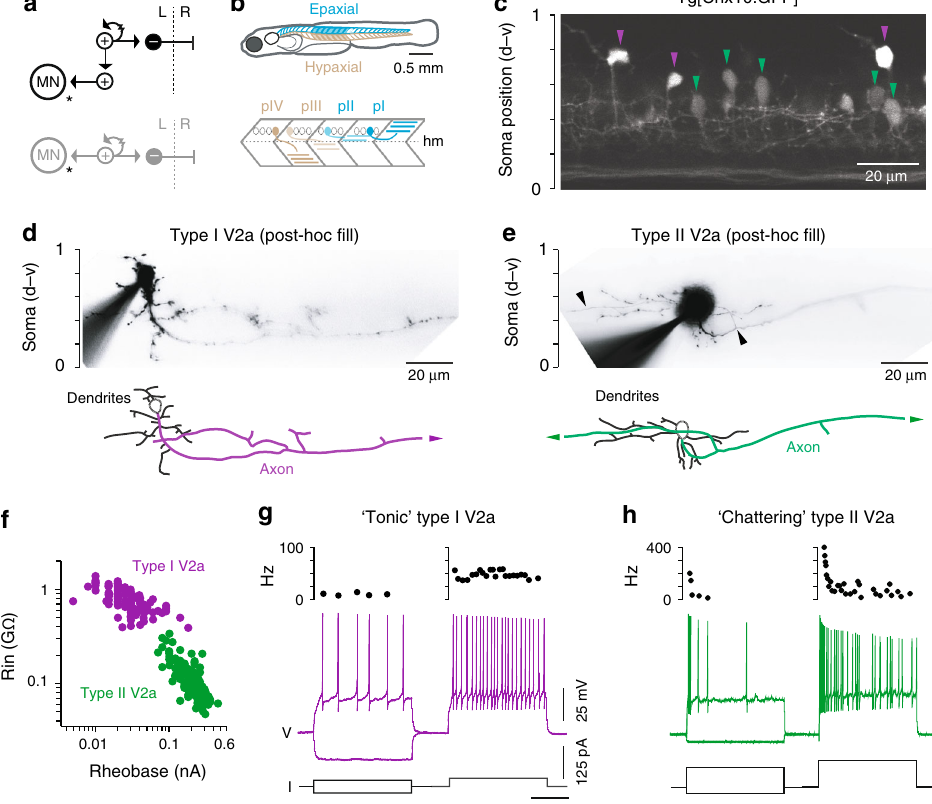
Fig. 1 Two types of V2a neuron distinguished by intrinsic properties. a Schematics illustrating multi-layer (top) and single-layer (bottom) models of connectivity underlying timing and amplitude control. + excitatory interneurons, – inhibitory interneurons, MN motor neurons, L left side, R right side. Arrows are glutamatergic connections and the resistor symbol denotes electrical coupling. b Top, schematic illustrating a larval zebra fi sh viewed from the side. Region at midbody (segments 10 – 16) where recordings were performed is shaded. Rostral, left; dorsal, up. Bottom, schematic illustrating muscle segments and each of the four identi fi ed primary motor neurons per spinal hemisegment (dotted circles) that innervate either epaxial (pI-II) or hypaxial (pIII-IV) muscle (horizonal blue or brown lines). hm, horizontal myoseptum. c Single confocal optical section from one spinal segment illustrating type I (purple arrowheads) and type II (green arrowheads) V2a neurons targeted for recordings. Soma positions are normalized to the dorsal and ventral aspects of spinal cord (d-v). Rostral is to the left. d Top, contrast inverted epi fl uorescent images of fi lls after electrophysiological recordings. Bottom, reconstructions illustrating the trajectory of the main axon. The descending axon of the type I V2a neuron continues out of the fi eld of view (arrowhead). Scale to the left indicates normalized dorso-ventral soma position. e As in panel d , but for a bifurcating type II V2a neuron. In top image, black arrowheads mark axon bifurcation point and the continuation of the ascending axon out of the fi eld of view. f Quanti fi cation of input resistance (Rin) and rheobase according to V2a neuron type. Type I V2a ( n = 105), type II V2a ( n = 145). Source data are provided in a Source Data fi le. g Top, instantaneous fi ring frequencies are plotted above the respective recordings from a type I V2a neuron. Bottom, examples of voltage de fl ections in response to a hyperpolarizing current step ( – 25 pA) and fi ring responses to current steps around threshold (left trace) and just above threshold (right trace). Voltage; I, current. Source data are provided in a Source Data fi le. h , As in panel g , but for a type II V2a